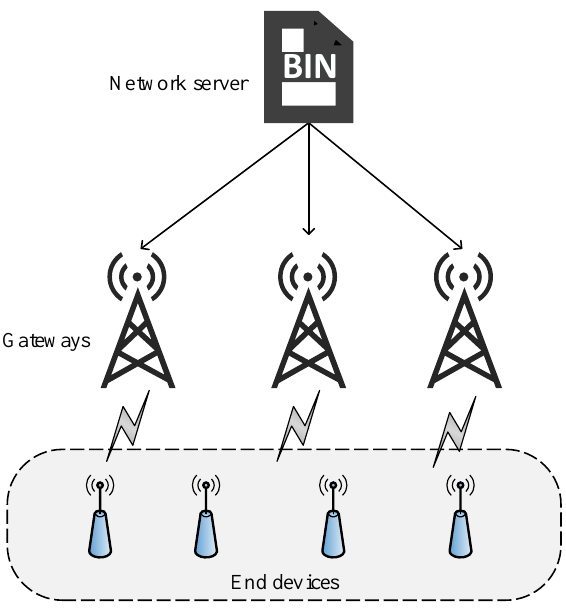
Figure 6. Network server process of firmware update in